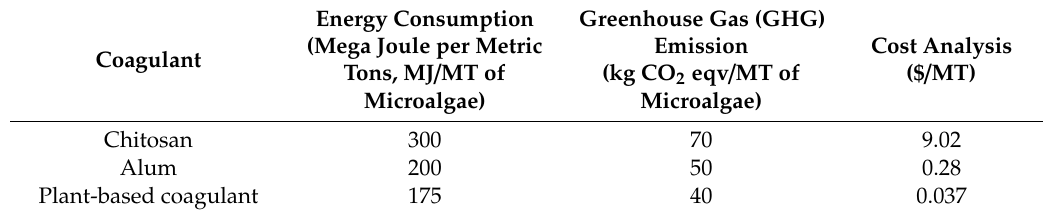
Table 5. Comparison of cost analyses between natural coagulants and alum to harvest microalgae